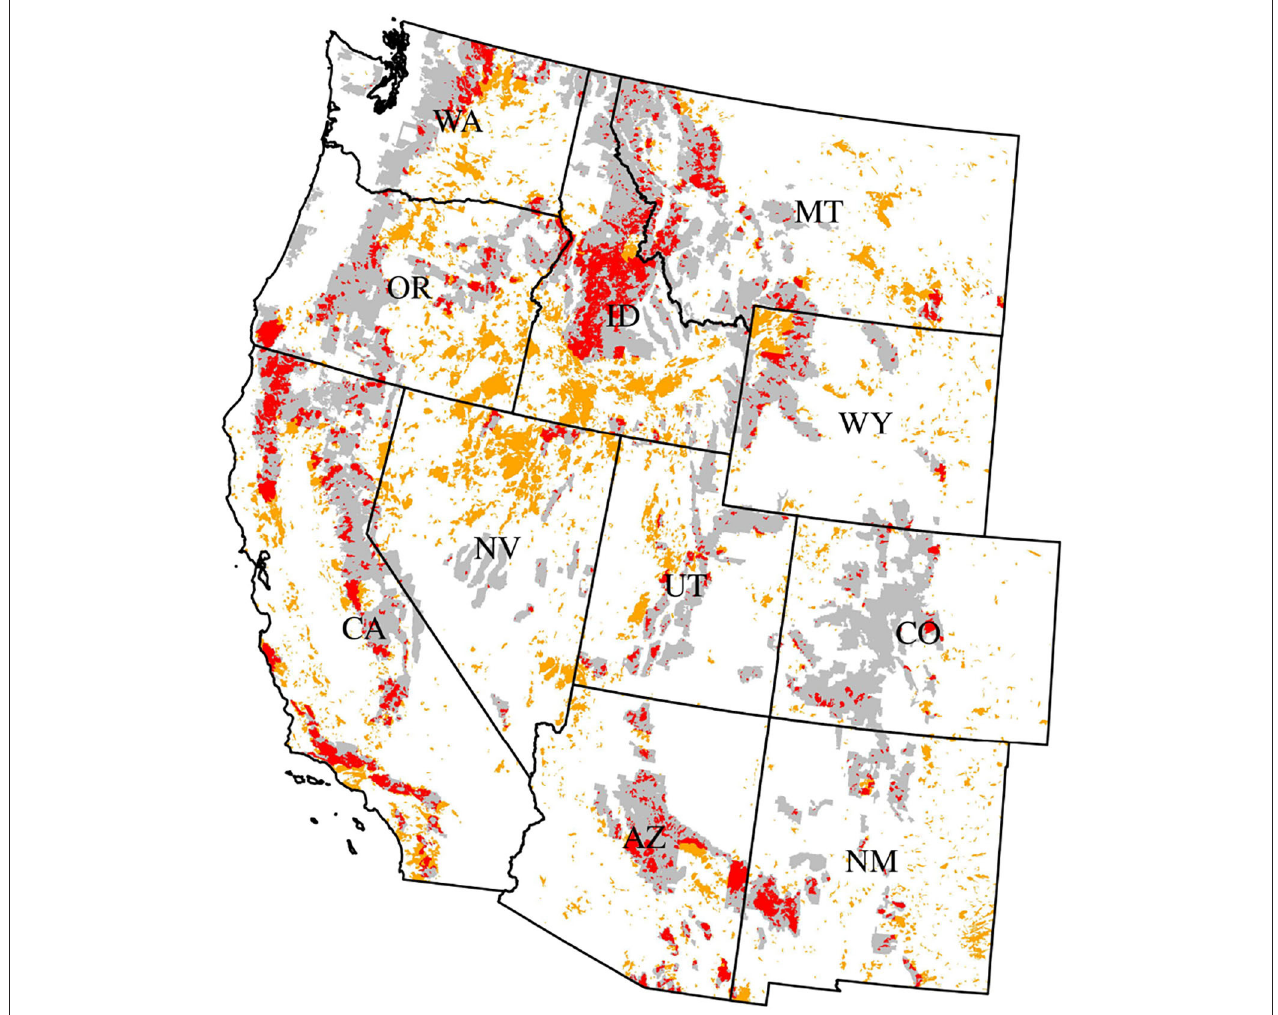
FIGURE 1 | Study area spanning 11 states in the western USA. Areas spanned by MTBS burn polygons 1984–2018 are shown in red where they overlap USFS National Forest System (NFS) lands and in orange otherwise; unburned NFS lands are shown in gray.